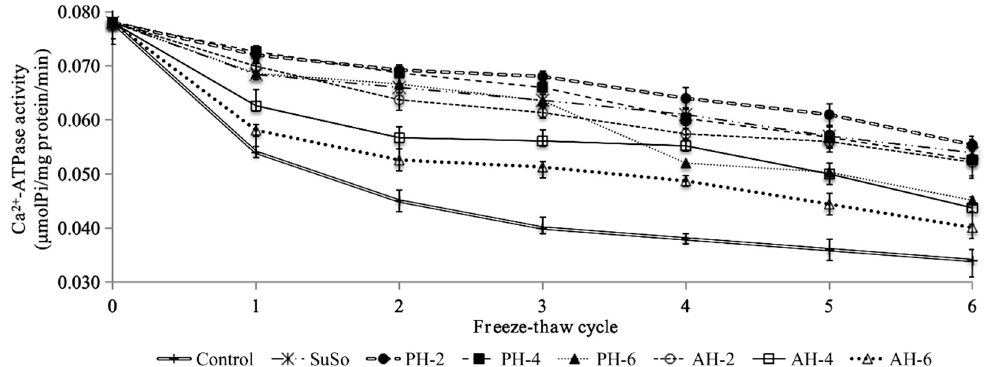
Figure 3. Ca 2+ -ATPase activity of actomyosin from different surimi samples during freeze-thaw cycles. SuSo (surimi added with sucrose-sorbitol blend); PH-2, PH-4 and PH-6 (surimi with addition of 2, 4, and 6 g of the hydrolysate prepared by Protamex hydrolysis, respectively); AH-2, AH-4 and AH-6 (surimi with addition of 2, 4, and 6 g of the hydrolysate prepared by Alcalase hydrolysis, respectively); and control (surimi without cryoprotectant). The reported data represent mean values from three replications. Bars represent standard deviations.